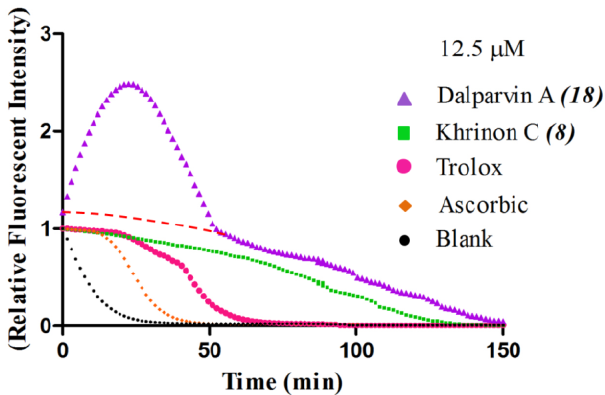
Figure 1. Fluorescence decay curve induced by AAPH. The signal curves of some of the tested compounds compared with that of the blank. The extrapolating decay line from the unusual experimental curve of dalparvin A ( 18 ) is indicated by the red dashed line